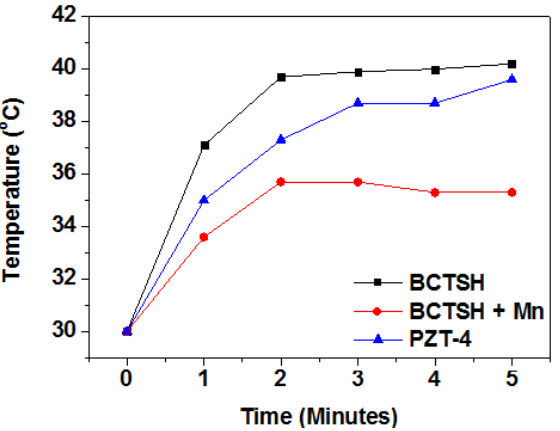
Figure 11. The rise in temperature, Δ T, for BCTSH and BCTSH + Mn piezoelectric motors after 5 min at a driving voltage of 150 V P-P .